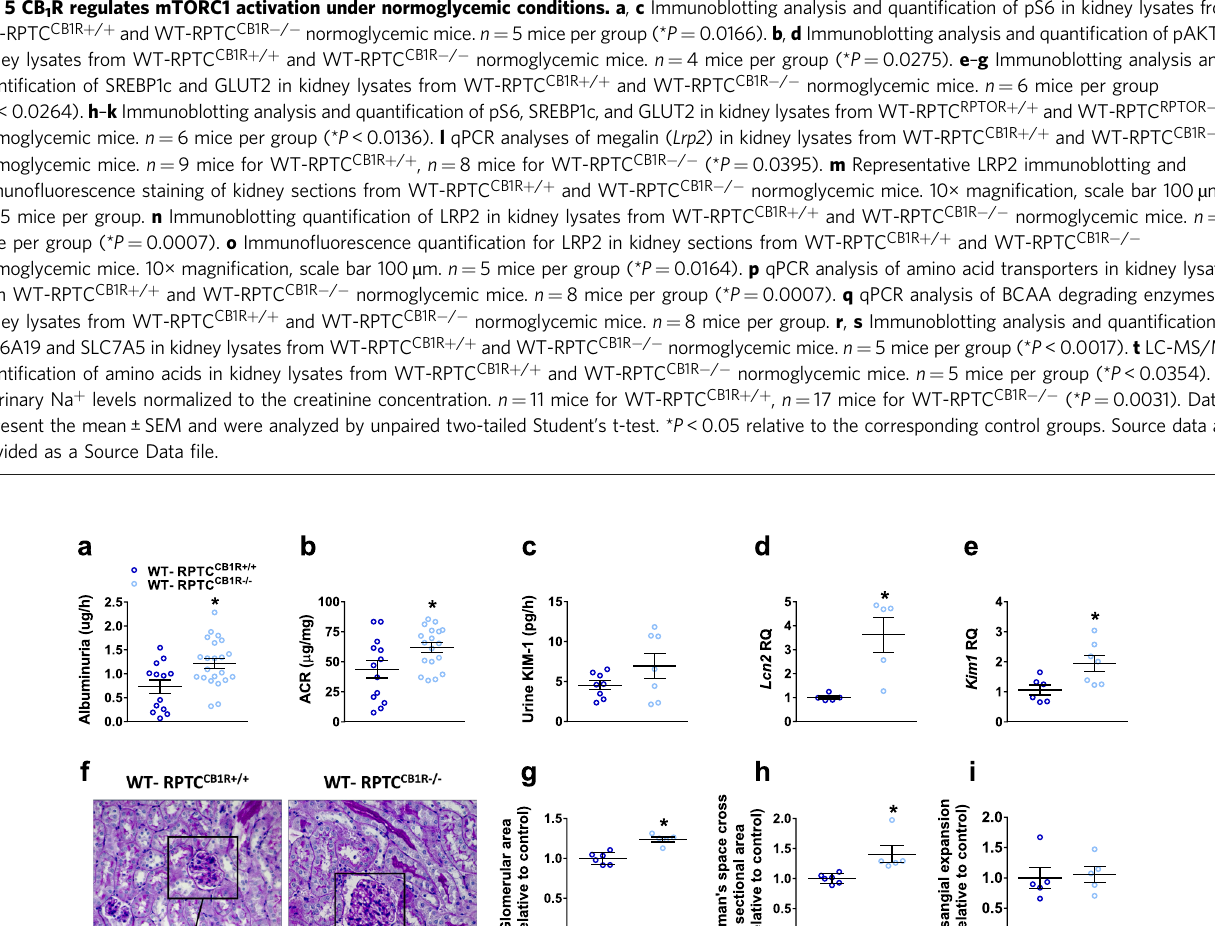
Fig. 5 CB 1 R regulates mTORC1 activation under normoglycemic conditions. a , c Immunoblotting analysis and quanti fi cation of pS6 in kidney lysates from WT-RPTC CB1R + / + and WT-RPTC CB1R − / − normoglycemic mice. n = 5 mice per group (* P = 0.0166). b , d Immunoblotting analysis and quanti fi cation of pAKT in